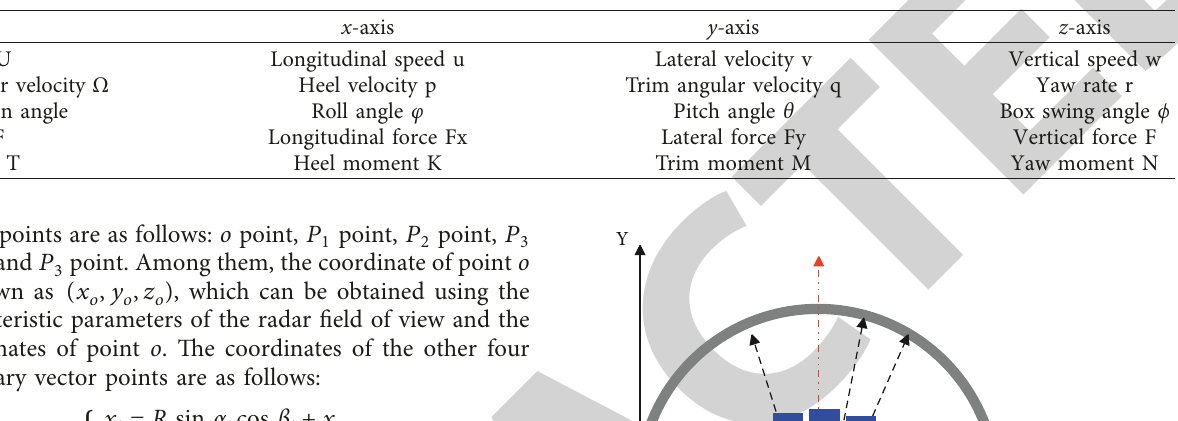
Table 2: Main symbols of the motion coordinate system.